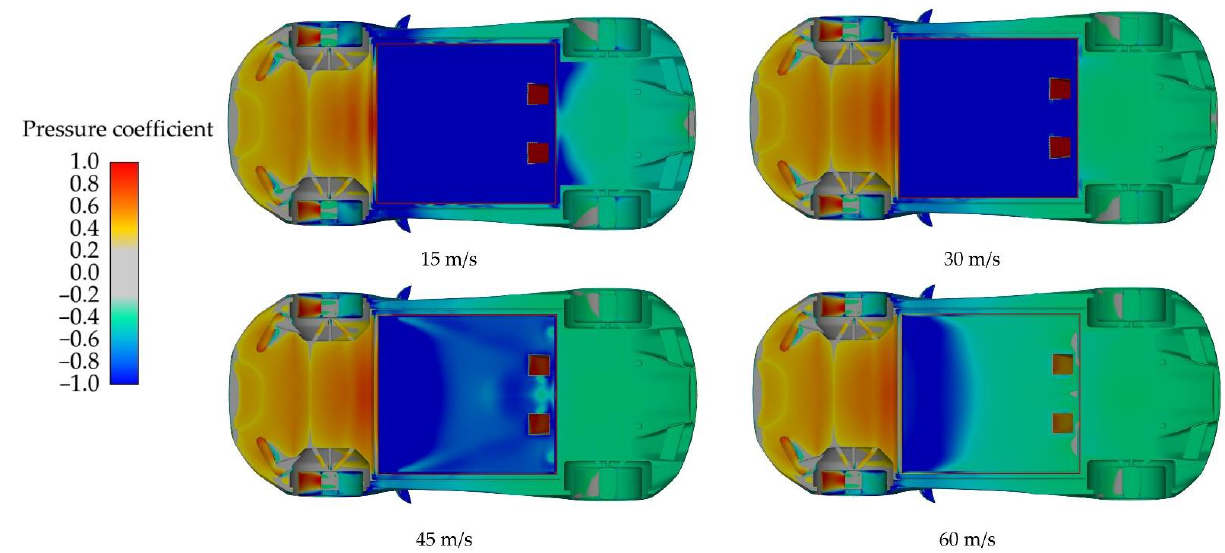
Figure 26. Pressure coefficient at the bottom surface for the case with fans turned on for various inlet speeds.